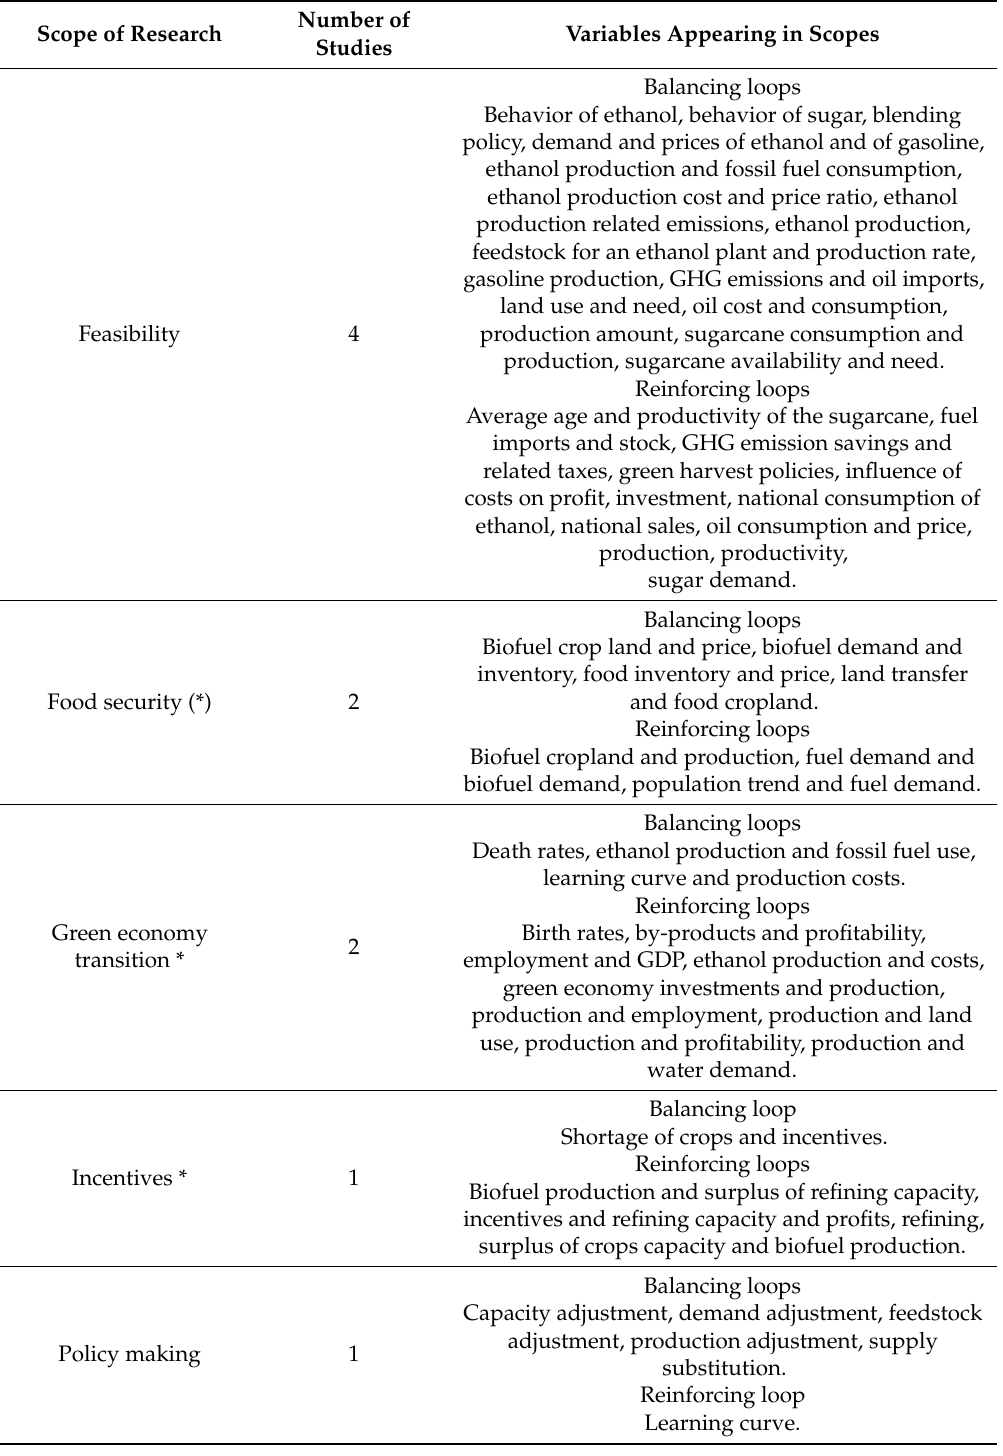
Table 2. List of loop variables according to the scopes of the